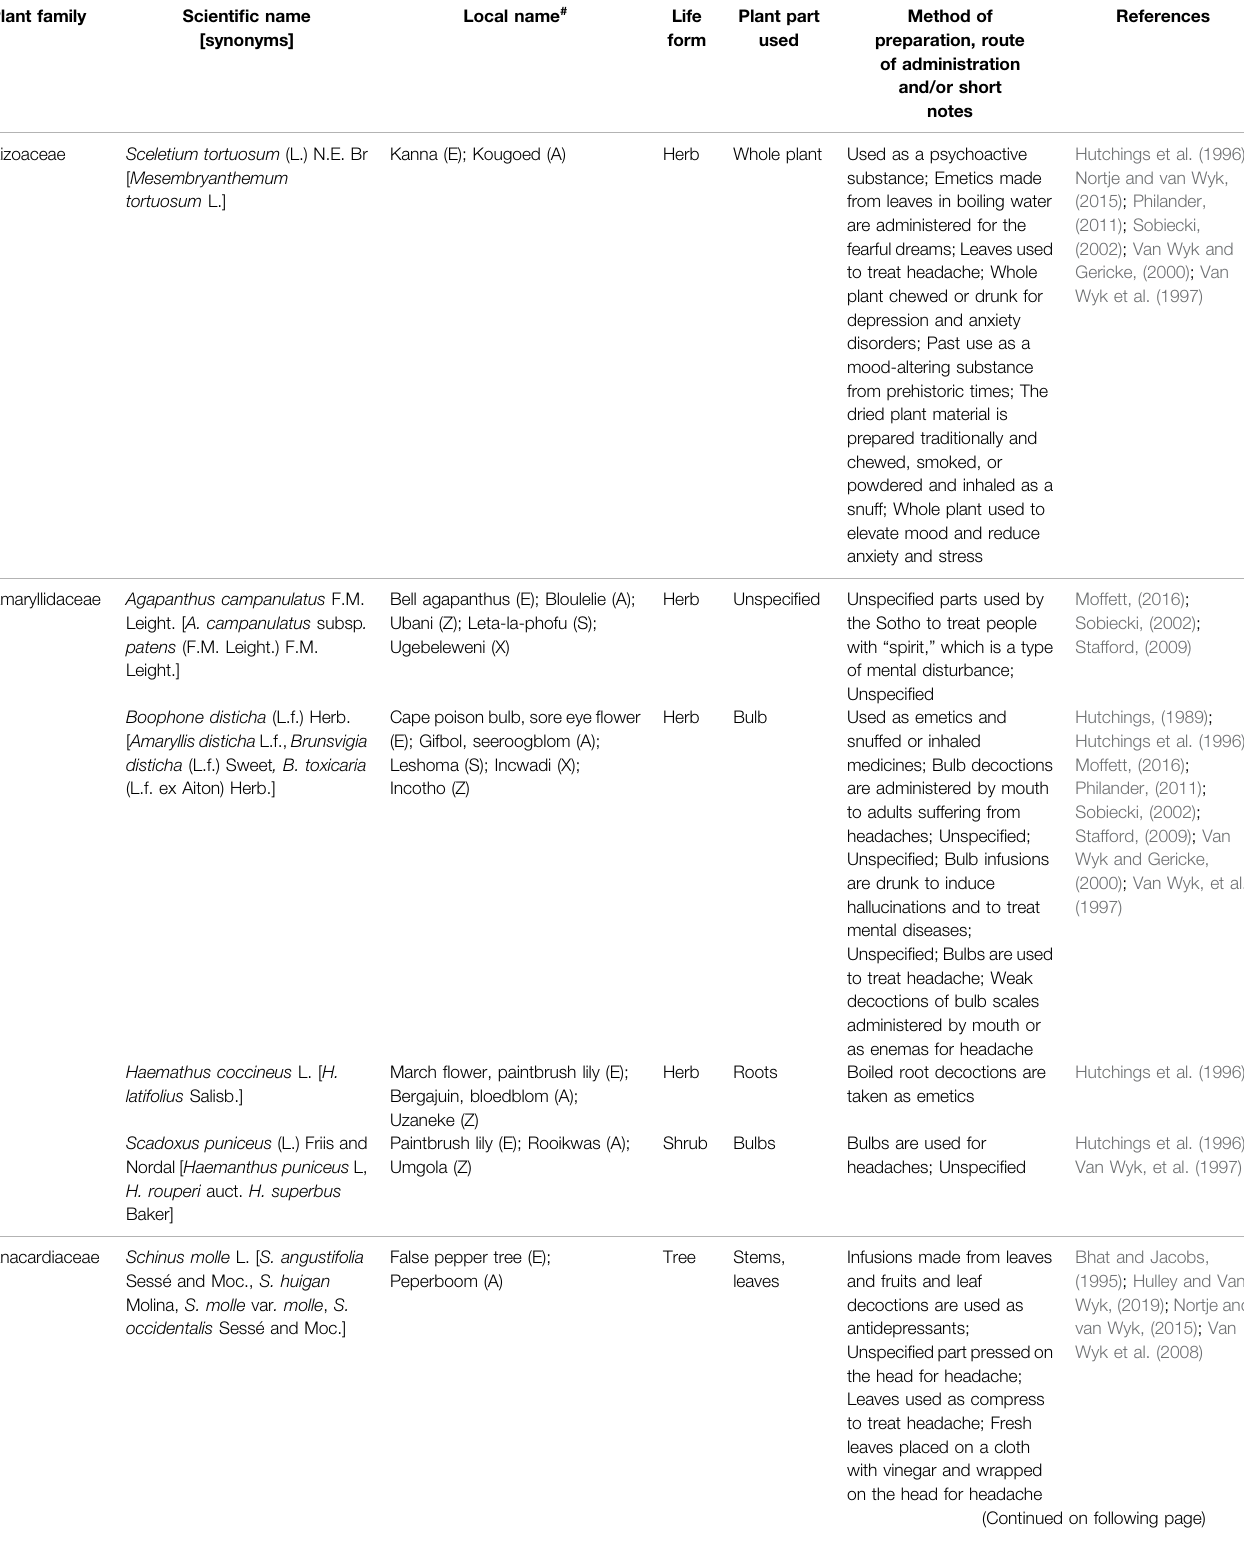
TABLE2| ExamplesofpopularmedicinalplantsusedagainstdepressionandrelatedailmentsinSouthAfricabasedonmultiplementionsinethnobotanicalliteratureandthe presence of pharmacological evidence. Plant